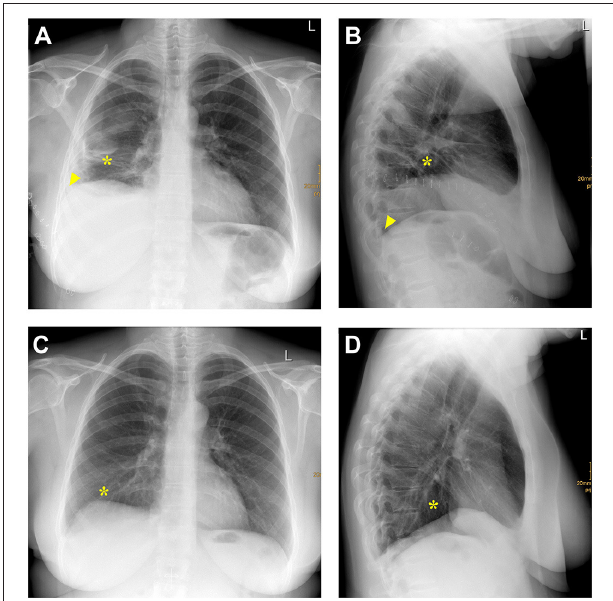
FIGURE 3 | (A,B) Posteroanterior (A) and lateral (B) chest X-ray one month after right-sided Bochdalek hernia repair and empyema evacuation. A right-sided pleural effusion (arrowhead) and opacity due to basal hypoventilation (star) accompanied by a moderate elevation of the right hemidiaphragm without any signs of hernia recurrence can be detected. (C,D) Posteroanterior (C) and lateral (D) chest X-ray one year after right-sided Bochdalek hernia repair and empyema evacuation. No signs of hernia recurrence and only a slight right-basal hypoventilation (star) can be